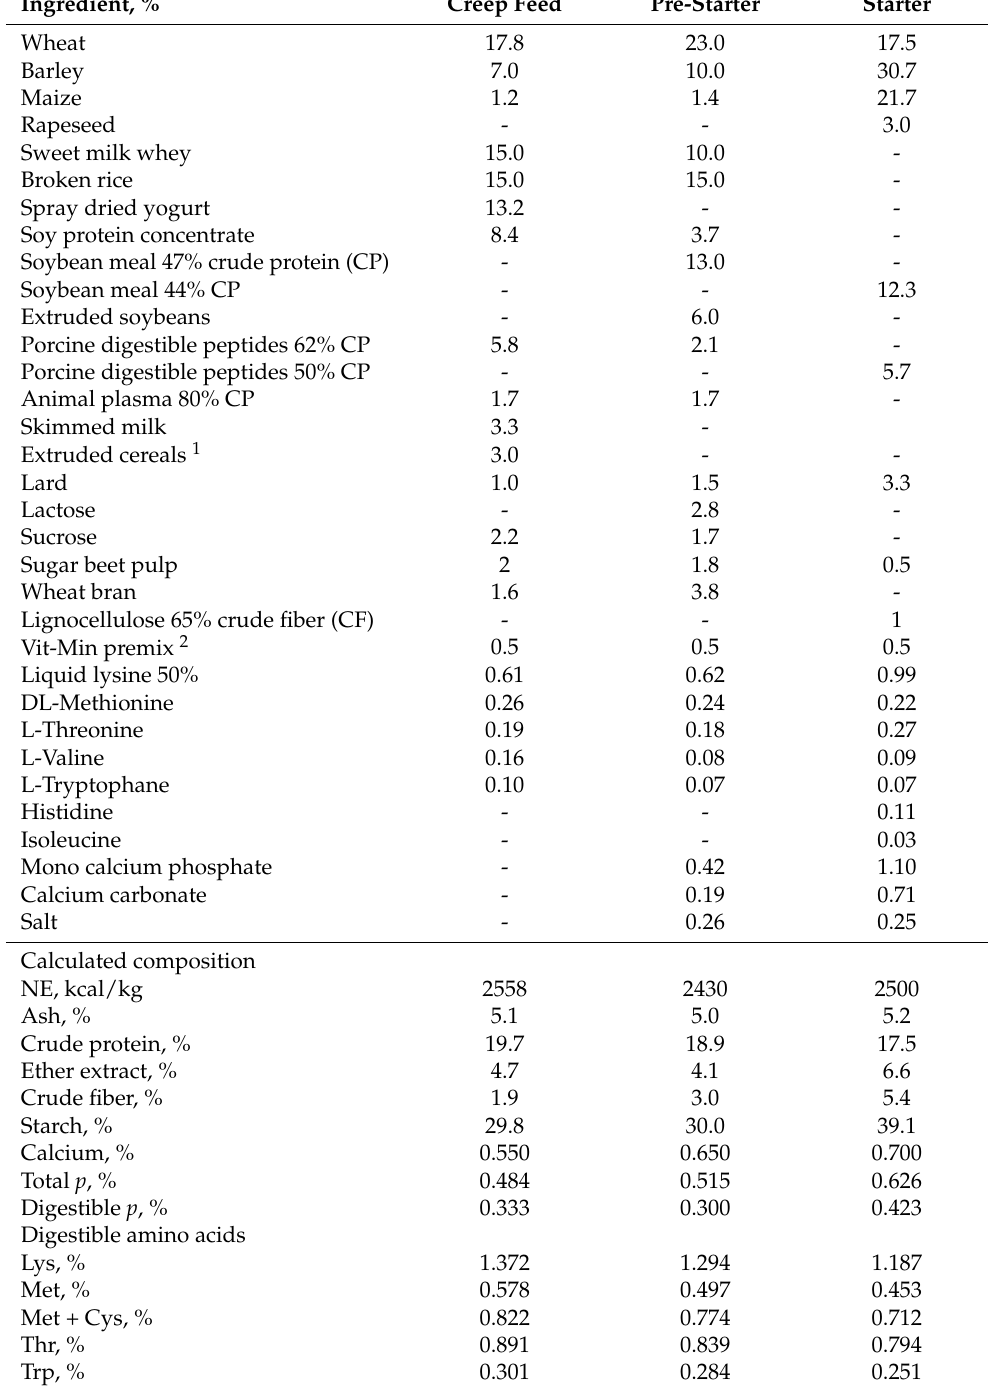
Table 2. Diets offered to the animals included in the